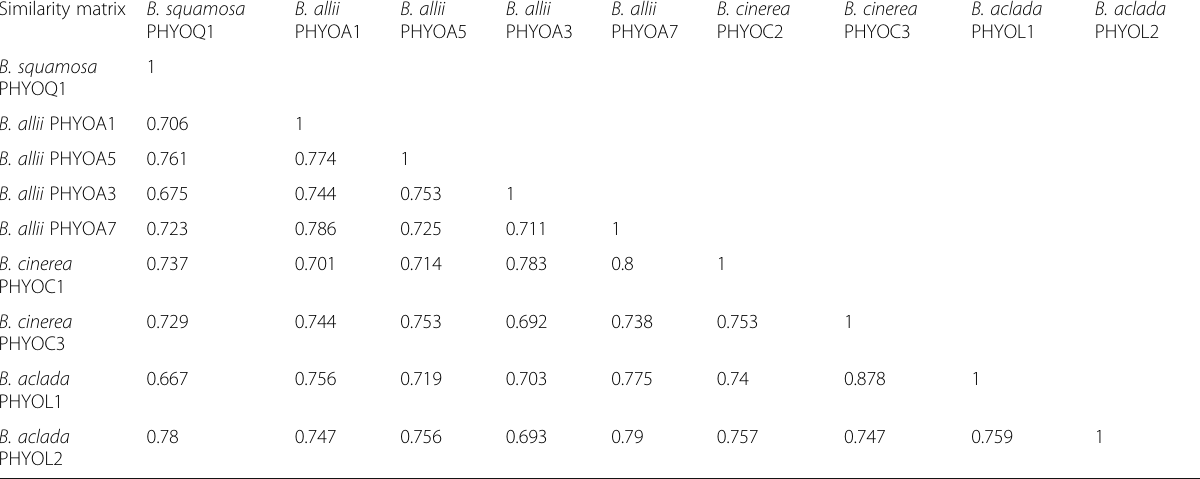
Table 4 Genetic similarity values calculated from total DNA fragments generated with five primers in nine Botrytis spp. Similarity matrix B. squamosa PHYOQ1